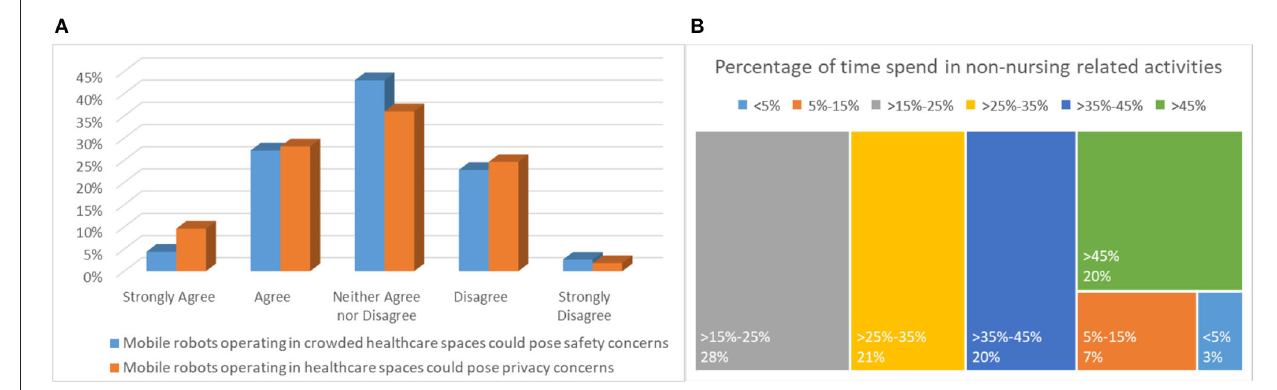
FIGURE 5 | (A) Safety and privacy considerations and (B) Operational perspective.